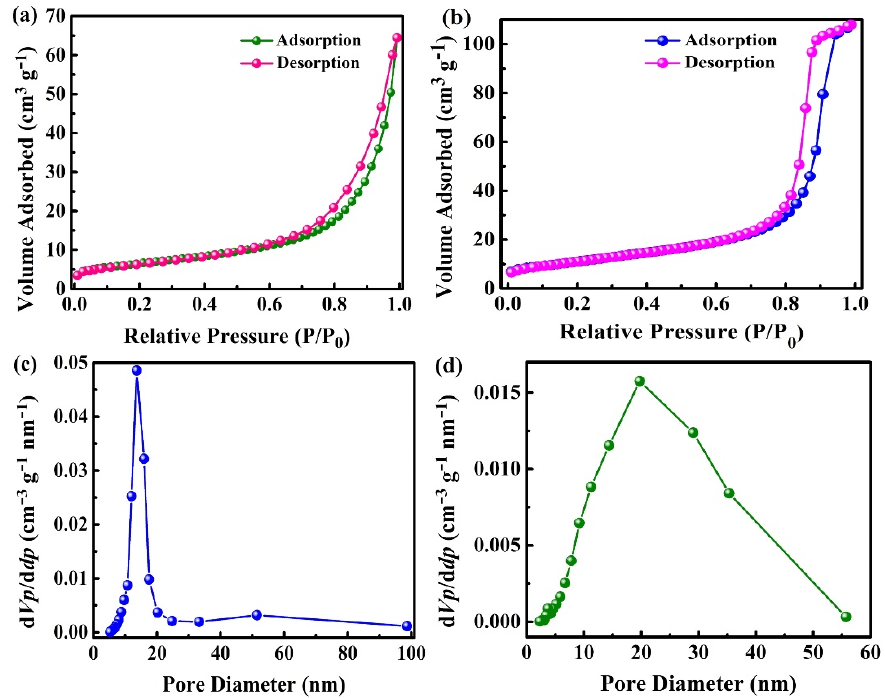
Figure 5. ( a , b ) N 2 adsorption–desorption isotherms and ( c , d ) the corresponding BJH pore size distribution of Li 2 TiO 3 and LiCoO 2 , respectively. distribution of Li 2 TiO 3 and LiCoO 2 ,